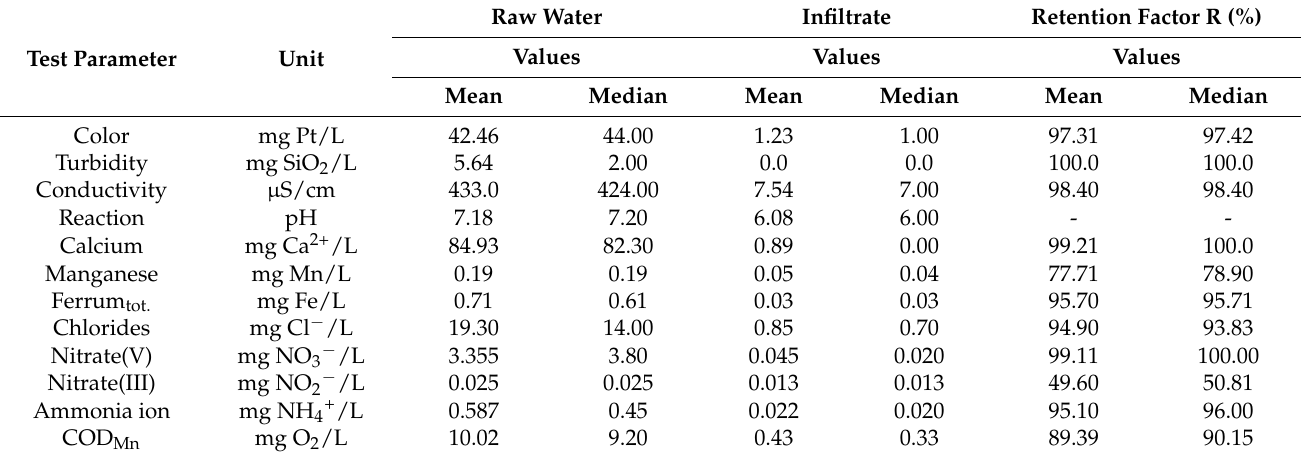
Table 1. Effectiveness of removing selected contaminants from infiltration water in the RO process.